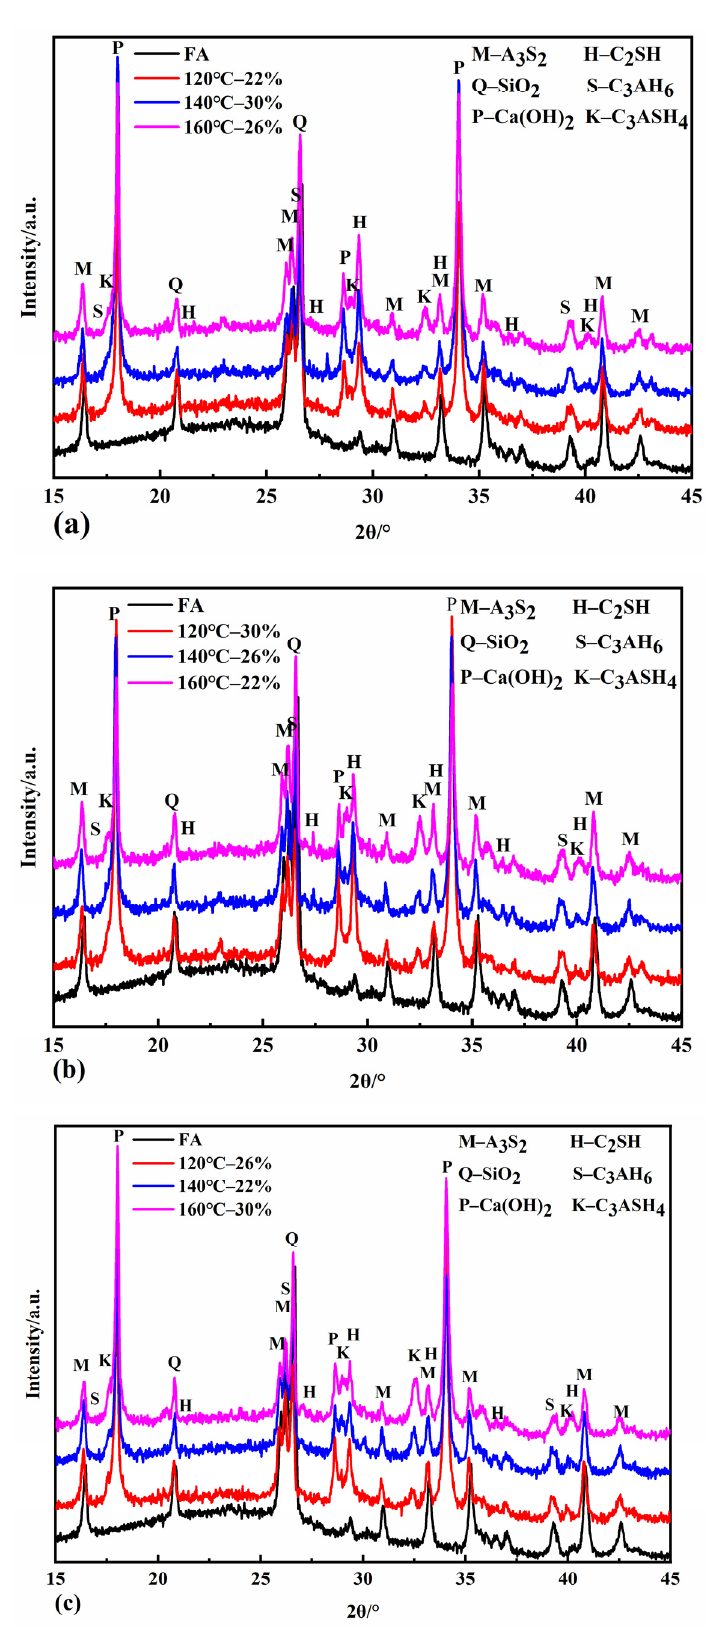
Figure 4. XRD patterns of samples autoclaved for 4 h ( a ), 6 h ( b ), and 8 h ( c ).